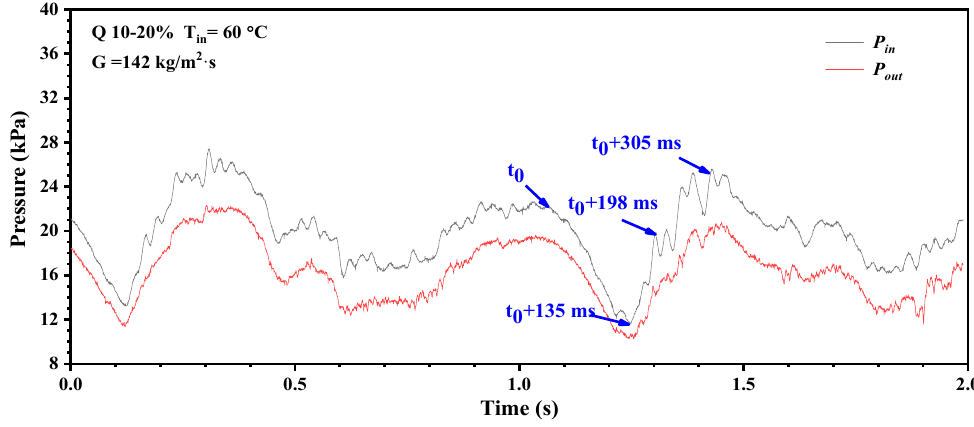
Figure 12. Pressure fluctuation curve of sample Q10-20% (q eff = 121.2 W/cm 2 ).